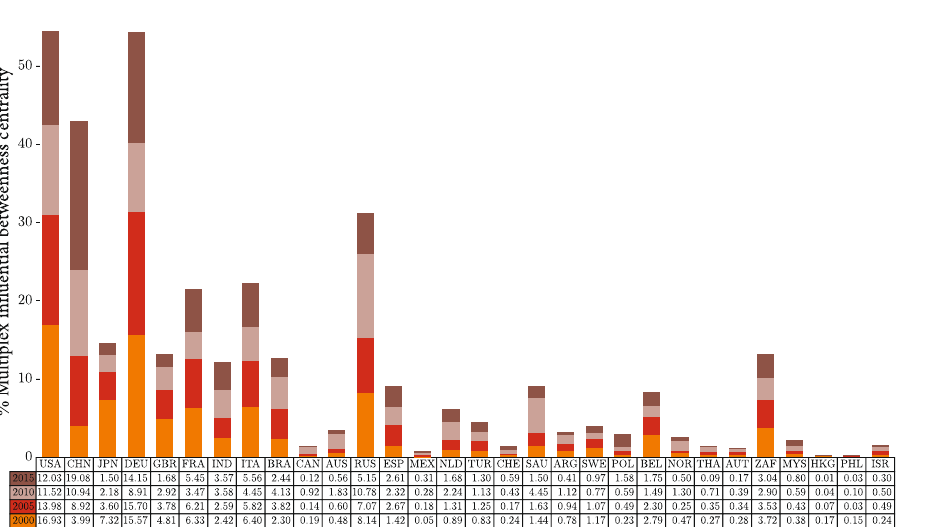
Figure 2. Representation of multiplex influential betweenness centrality for every node in Trade dataset. The bars show the percentage of multiplex influential betweenness centrality of 30 countries for four years. The countries are listed based on their GDP values in 2015 from left to